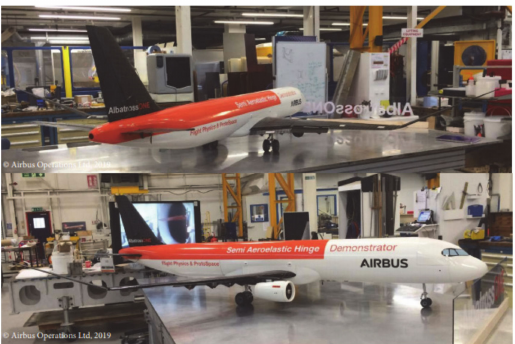
Figure 2. The AlbatrossONE flying demonstrator equipped with SAH “Reprinted from